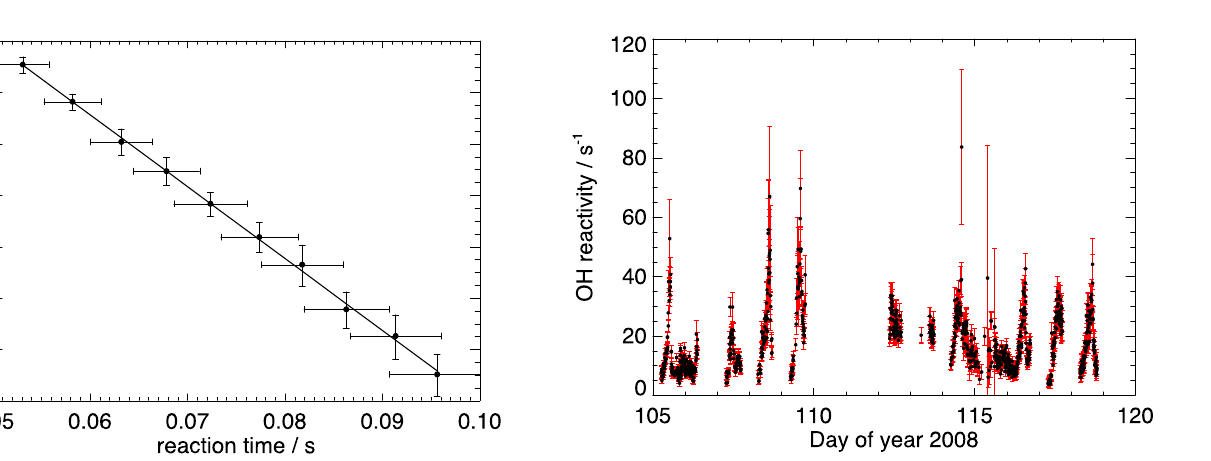
Figure 2: Decay of OH measured between 12:25 – 12:27 Malaysia Time Zone (UTC + 08.00 Figure 3: OH reactivity observation time series for the OP3 campaign, with error bars h) on 21 April 2008 during the OP3 campaign, showing the line of best fit used to calculate Fig. 2. Decay of OH measured between 12:25–12:27 Malaysia time indicating the 1 σ uncertainty of the measurements described in Sect. 3. Fig. 3. OH reactivity observation time series for the OP3 campaign, the OH reactivity. The linear least squares fit to this decay yields an OH reactivity of 22.8 ± with error bars indicating the 1 σ uncertainty of the measurements zone (UTC + 8h) on 21 April 2008 during the OP3 campaign, 2.9 s -1 , after the subtraction of k ’ phys . Error bars represent the 1 σ variability on the OH signal described in Sect. during each 10 s measurement and the total calculated 1 σ uncertainty on the residence showing the line of best fit used to calculate the OH reactivity. time. 22 . 8 ± 2 . 9s − 1 , after the subtraction of k 0 . Error bars represent A reduction in the OH reactivity from the true value due to the conversion of HO 2 (which is phys generated together with OH inside the injector) to OH by its reaction with NO has been average NO concentration during the period of OH reactivity observations was 42 pptv. At perturb the OH decay [Ingham et al., 2009].